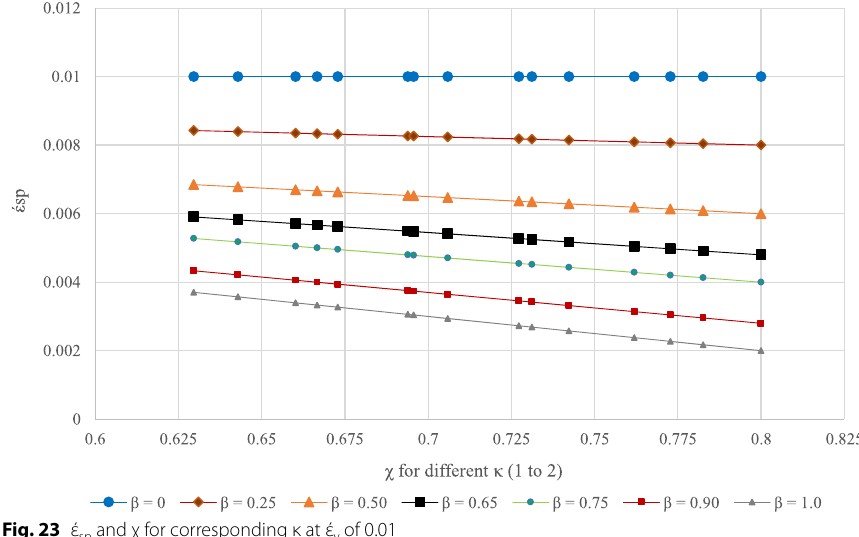
Fig. 23 έ sp and χ for corresponding κ at έ y of